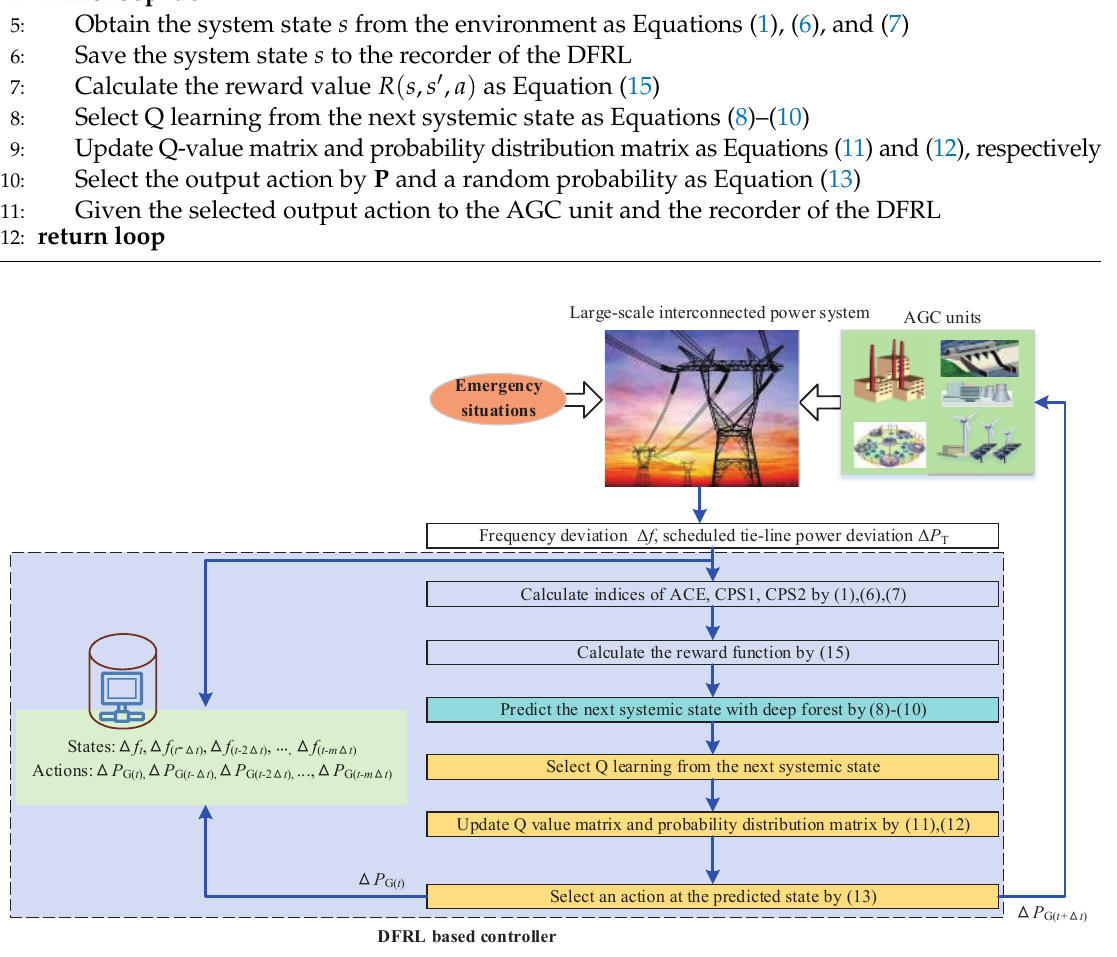
Figure 5. Flowchart of the deep forest reinforcement learning method for automatic generation control